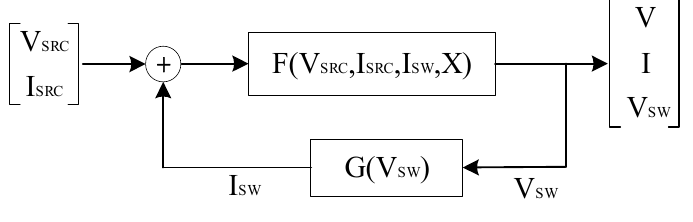
Figure 3. CDMS modeling block diagram.